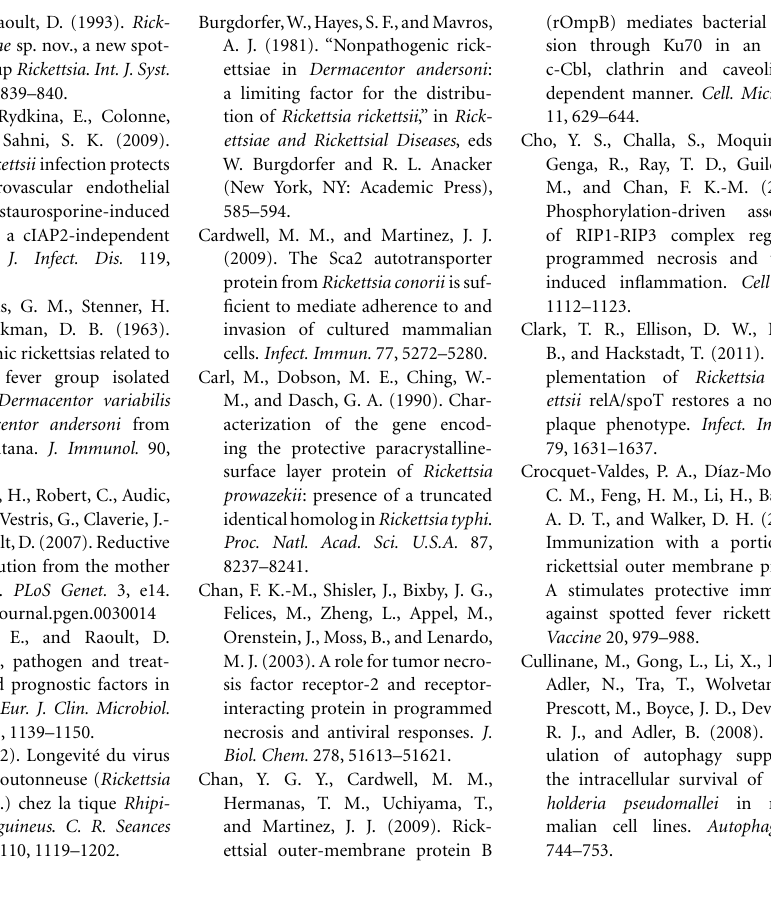
FIGURE 6 |Transmission electron microscopy ofVero cells infected with non-pathogenic and pathogenic SFGR. (A) Vero cells infected with R. montanensis alone was observed at 7days after infection. An arrow marks a degenerating rickettsia in an autophagosome-like vacuole. (B) R.